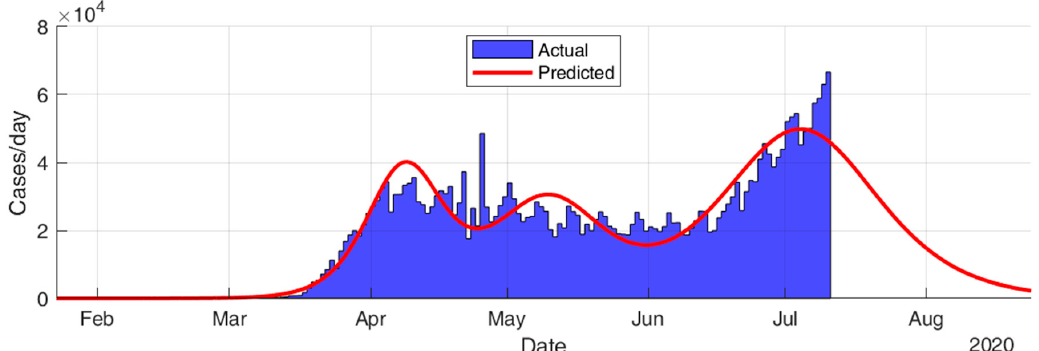
Figure 17. Prediction results for infection cases in Ireland.